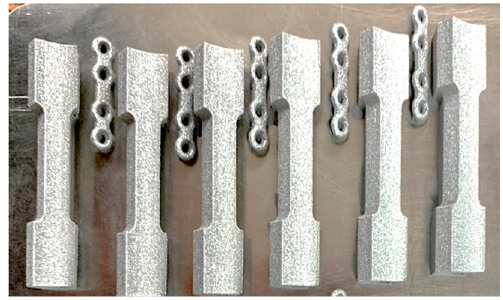
Figure 6. NiTi porous bone fixation plates and tensile samples fabricated via the SLM method.